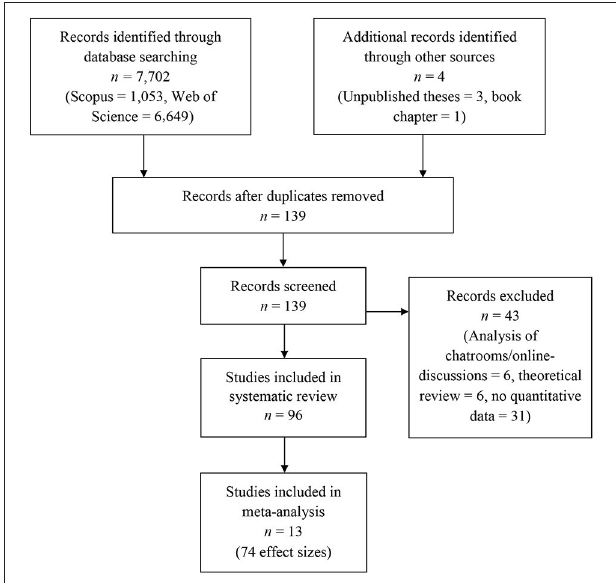
FIGURE 1 | PRISMA flowchart of screening, exclusion, and inclusion